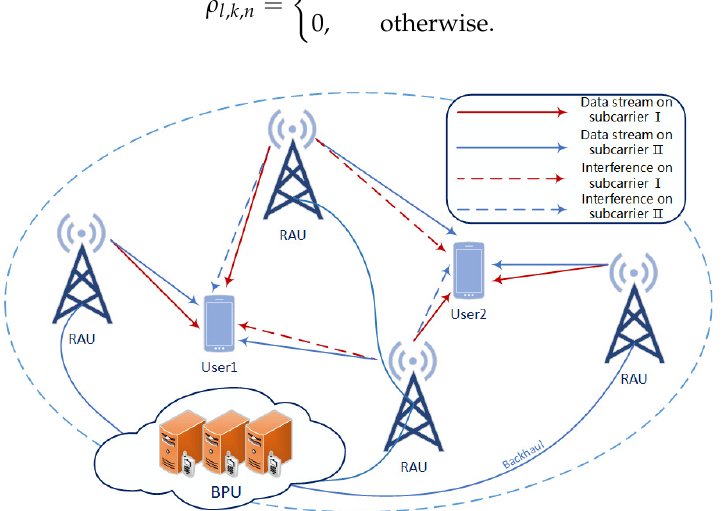
Figure 1. Illustration of the multi-TRP system with